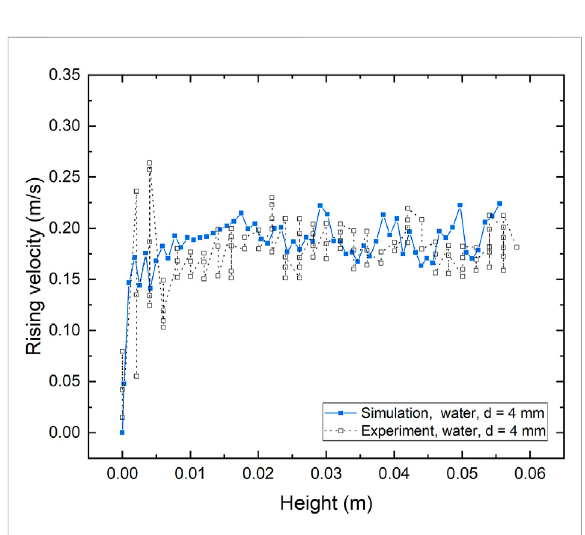
FIGURE 5 Comparison of 3D simulation and experiments of bubble rising velocity with height in water.